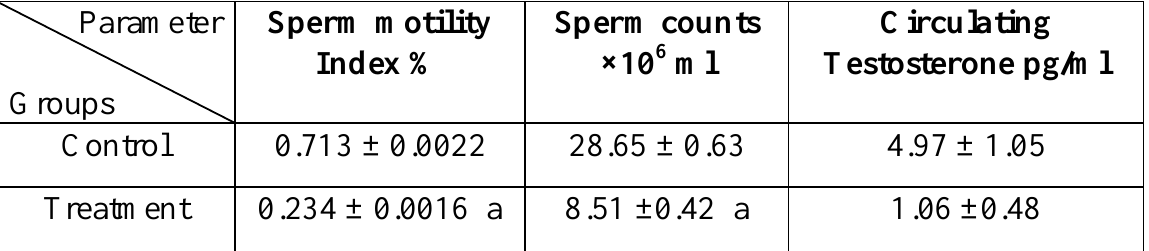
Table (1): Effect of 42 days treatment Gossypol by (40 mg/ kg BW/ day) on sperm motility index, sperm concentration and plasma Testosterone level of